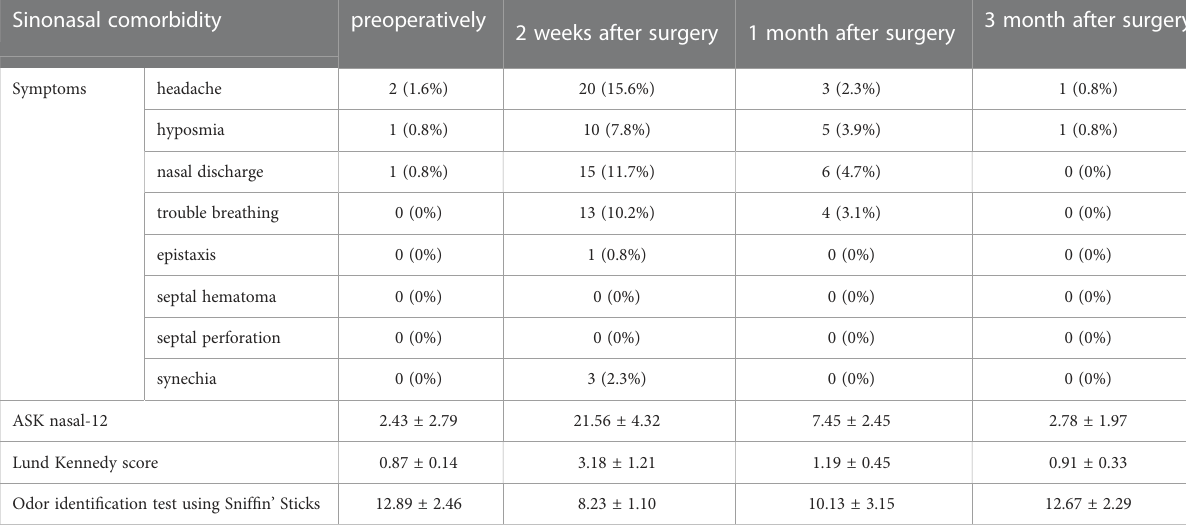
TABLE 3 Sinonasal comorbidity after surgery. Sinonasal comorbidity